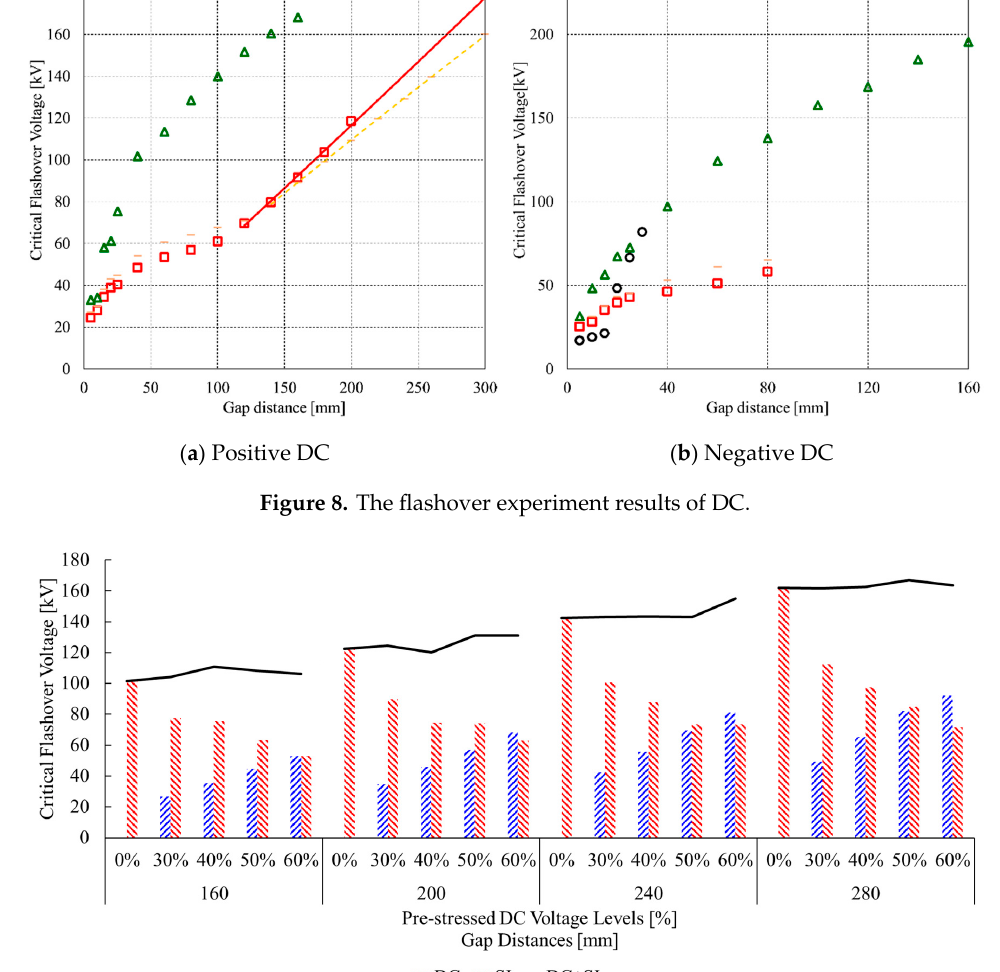
Figure 11. The experiment results of positive DC superimposed negative switching impulse for R10.